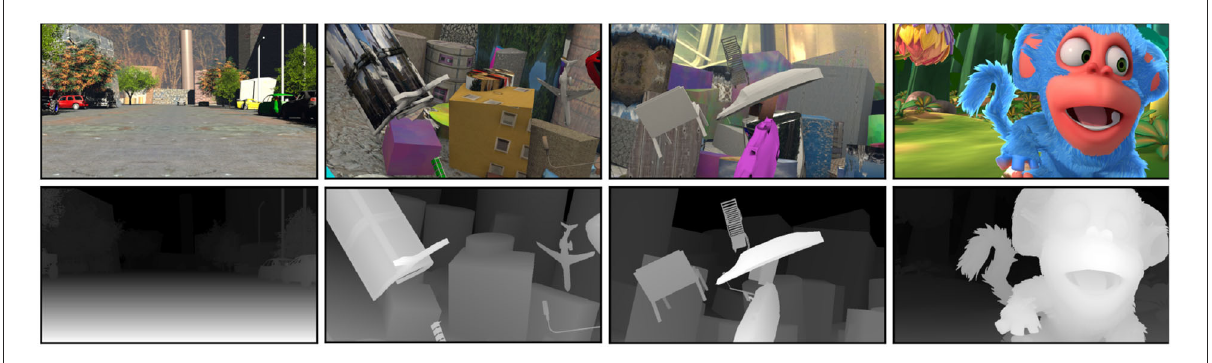
FIGURE4 Visualization of scene flow dataset.